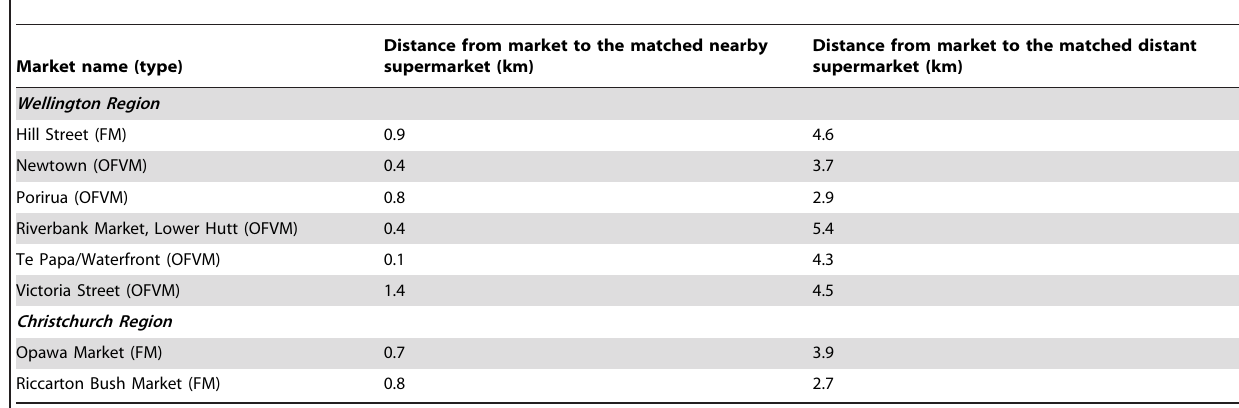
Table 1. Markets studied and distance from matched supermarkets in the Wellington and Christchurch regions included in this pricing